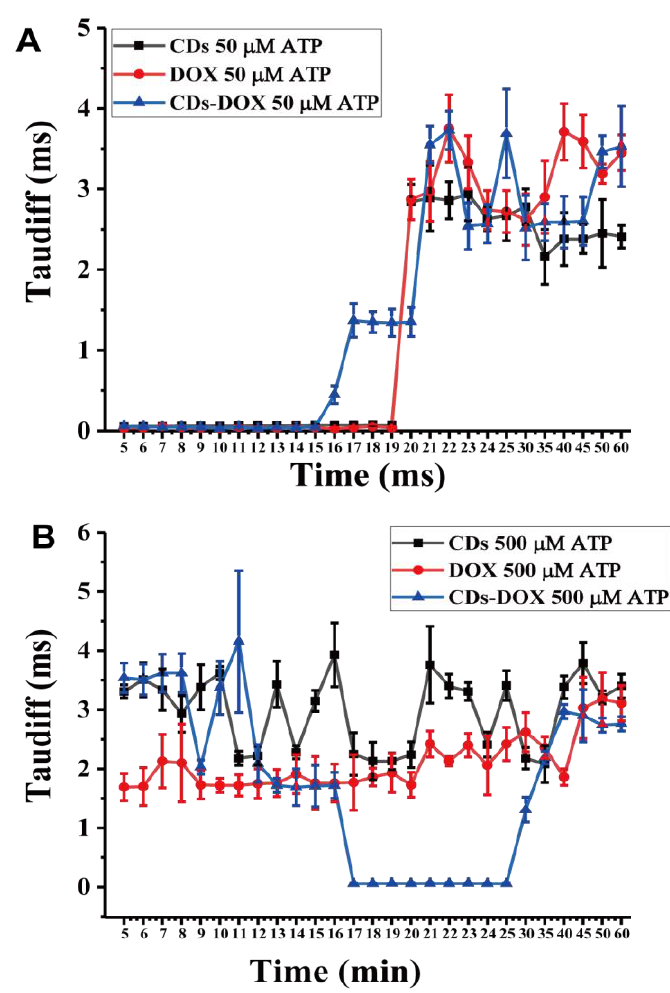
Figure 5. The effect of ATP concentration on drug transmembrane transport. The diffusion times changed with time when the ATP concentrations were 50 µM ( A ) and 500 µM ( B ). Cells were preincubated with 50 μL ATP at different concentrations and for 5 min prior to CDs , DOX and CDs-DOX addition. Error bars are given as the mean values ± standard deviation (SD) obtained from multiple samples (n = 9).